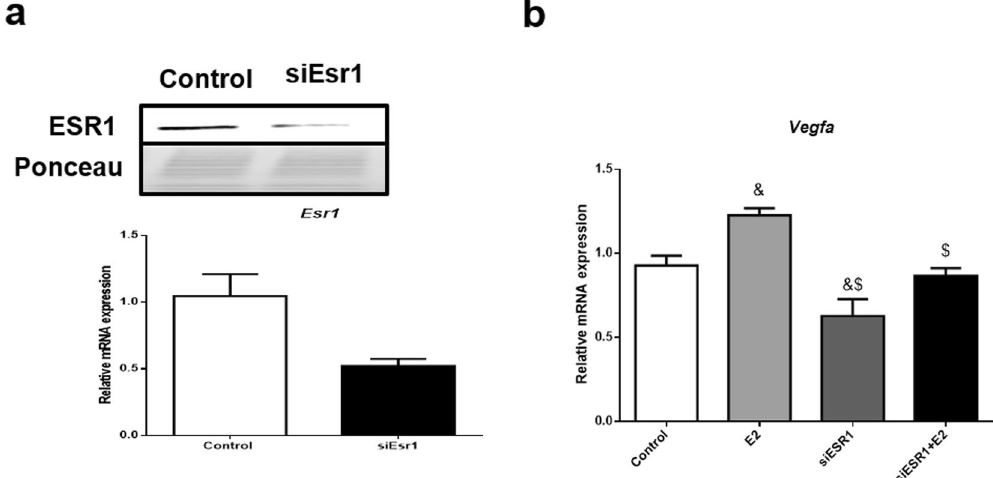
Figure 5. Effects of Esr1 silencing on VEGFA mRNA expression. Esr1 gene was knocked-down using siRNA, after 48 hours cells were treated with 10 nM of E2 and collected after 24 hours. Data were presented in mean ± SEM values. & p < 0.05 vs control; $ p < 0.05 vs E2 (n = 3 independent rounds of